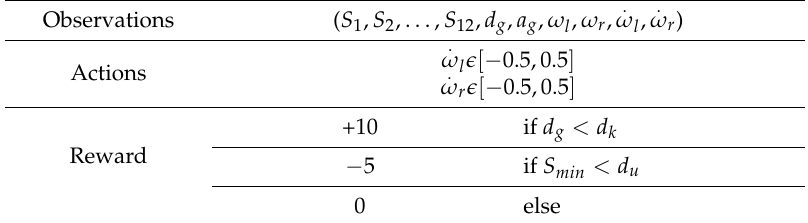
Table 1. Definitions of the Partially Observable Markov Decision Process